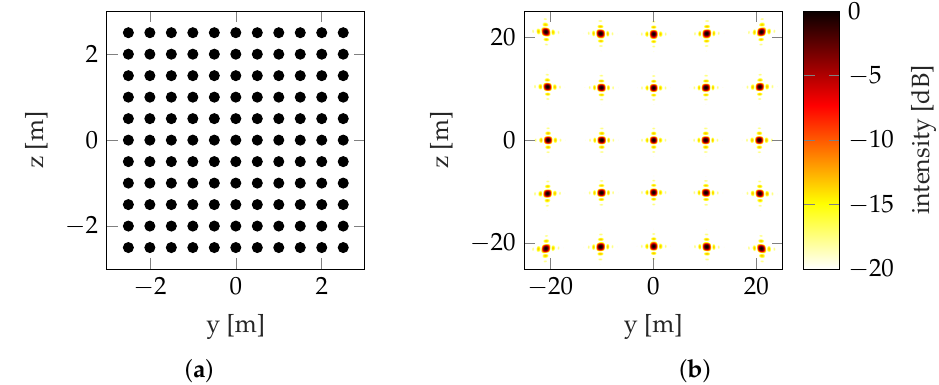
Figure 6. Evenly sampled aperture example: ( a ) Sampling points (“Trajectory”). ( b ) PSF. Evident grating lobes can be seen. If uniform sampling is replaced by random sampling (Figure 7), the grating lobes become smeared. In general, a sufficiently densely sampled aperture of dimension L H by L V provides δ H by δ V resolution when: